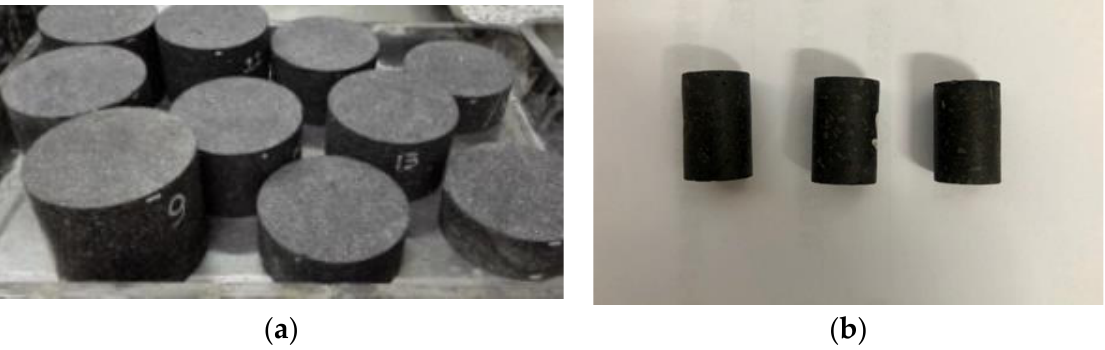
Figure 9. FAM specimens: ( a ) specimens of different heights; ( b ) core sample of medium III. Table 9. Thicknesses and void ratios of the FAM pieces.